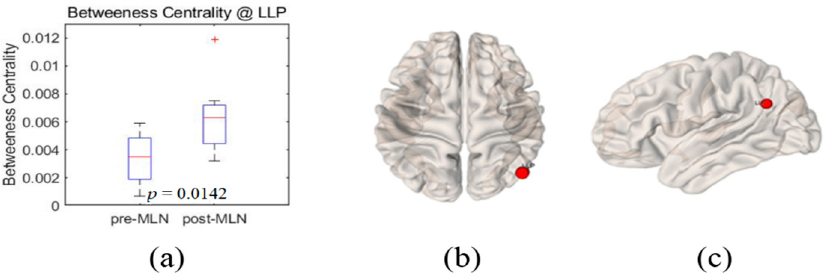
Figure 5. Illustrations of betweenness centrality change at the left lateral parietal cortex as the functional connectivity of neural network in fibromyalgia patients’ brains due to Milnacipran drug therapy. ( a ) Boxplots (left: before medication, right: after medication) of the distribution of the betweenness-centrality index at left lateral parietal cortex. The red markers indicate this location on the 3D brain surface in ( b ) transverse and ( c ) lateral views. Red color markers imply that the betweenness-centrality index statistically increased after the treatment of the MLN medication.